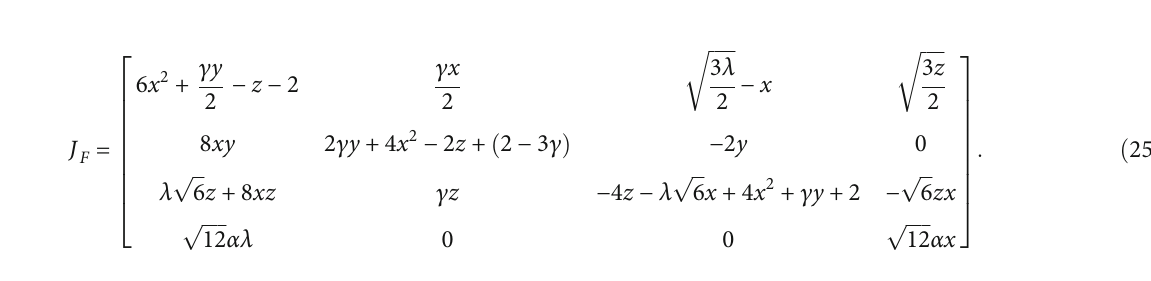
To fi nd the fi xed points, we equate x ′ , y ′ , z ′ , and λ ′ to 0. The fi xed points and corresponding cosmological parameters are shown in Table 3. The Jacobian matrices ( J ) for any fi xed point F ð x , y , z , λ Þ are given by